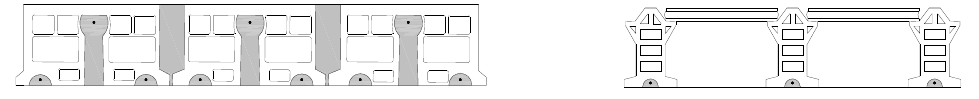
Figure 1. Di ff erent types of concrete solutions for typical Spanish “ceramic Figure 1. Different types of concrete solutions for typical Spanish “ceramic slabs”.